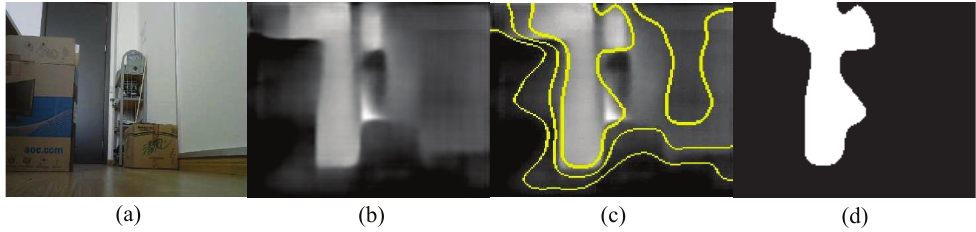
Figure 7. Superpixel segmentation and non-obstacle area extraction based on the depth map: ( a ) Orig- inal scene image, ( b ) Depth map, ( c ) Segmentation result, ( d ) Non-obstacle area.